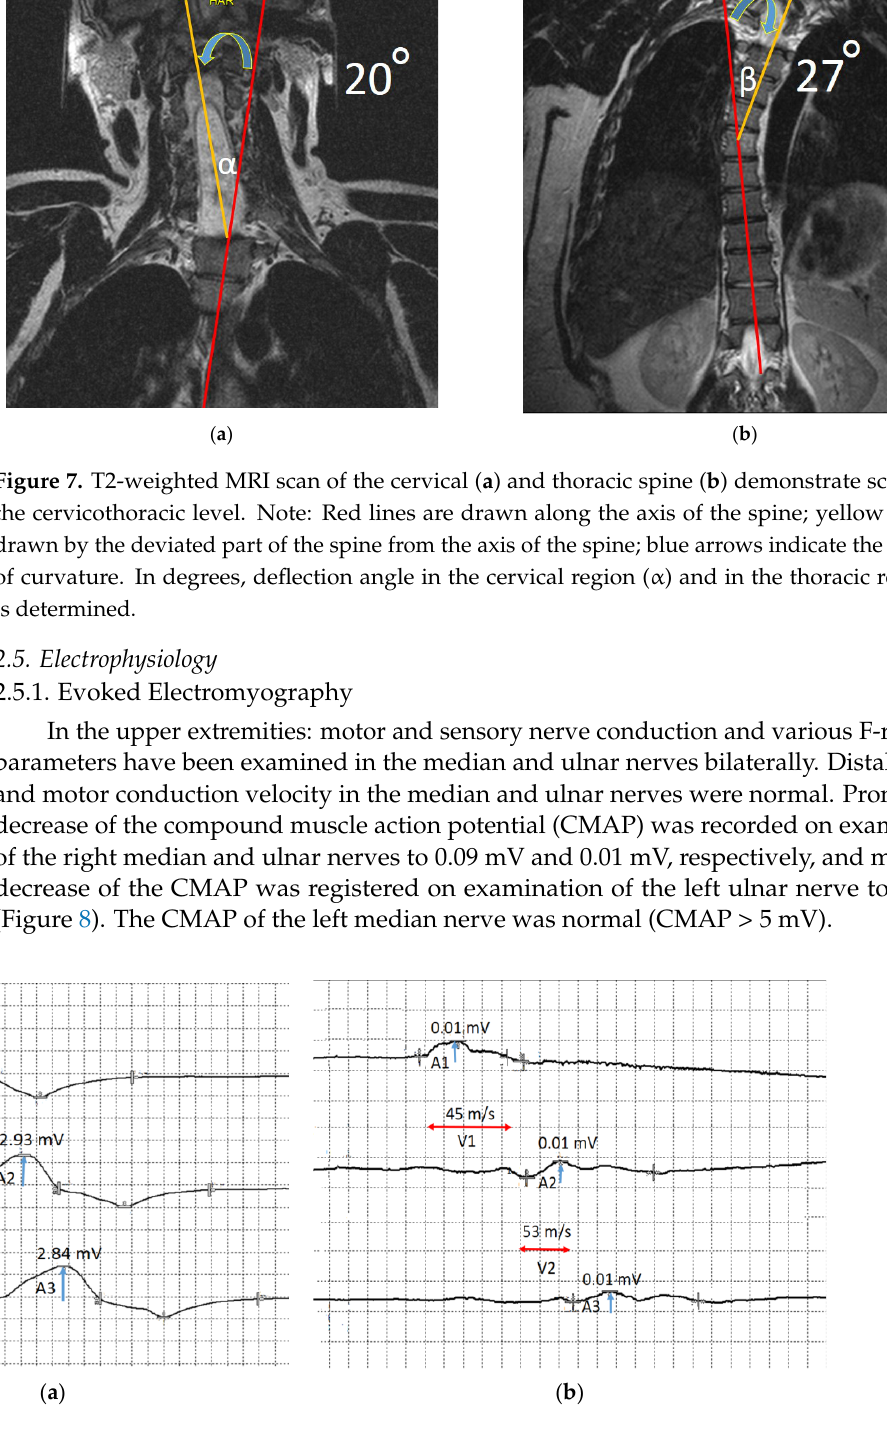
Figure 9. Sensory conduction velocity of the upper extremities nerves. ( a ) Sensory conduction ve- locity (V) and sensory nerve action potential amplitude of the left and right ulnar nerves. ( b ) Sensory conduction velocity (V) and sensory nerve action potential amplitude (A) of the left and right me- dian nerves. Blue arrows show compound muscle action potential amplitude and red arrows show conduction velocity. In the lower extremities: motor and sensory nerve conduction velocities, CMAP am- plitude, SNAP amplitude and various F-response parameters of the bilateral peroneal and tibial nerves were normal. Sural nerves studies showed normal conduction velocities and normal SNAP amplitude bilaterally.